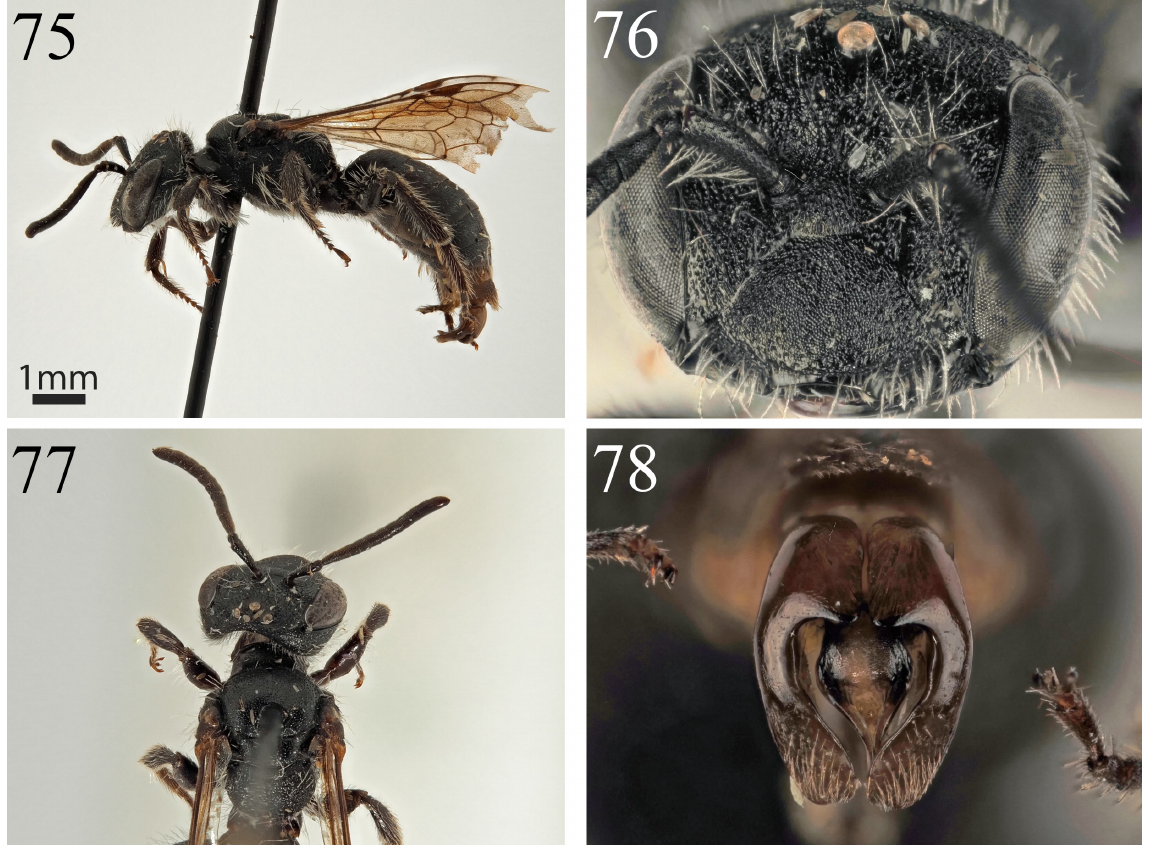
Figs 75–78. Andrena tabula Wood sp. nov., ♂ (OÖLM). 75 . Profile. 76 . Face. 77 . Dorsum. 78